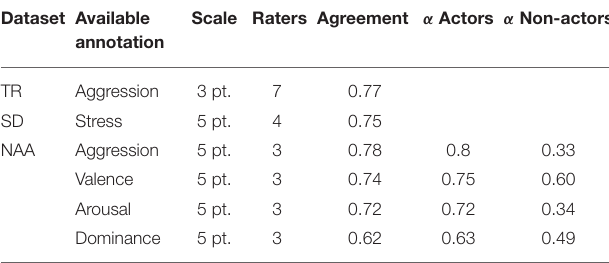
TABLE 2 | Available annotations per dataset, the number of raters and inter-rater agreement expressed as Krippendorf’s alpha for the original labels of the